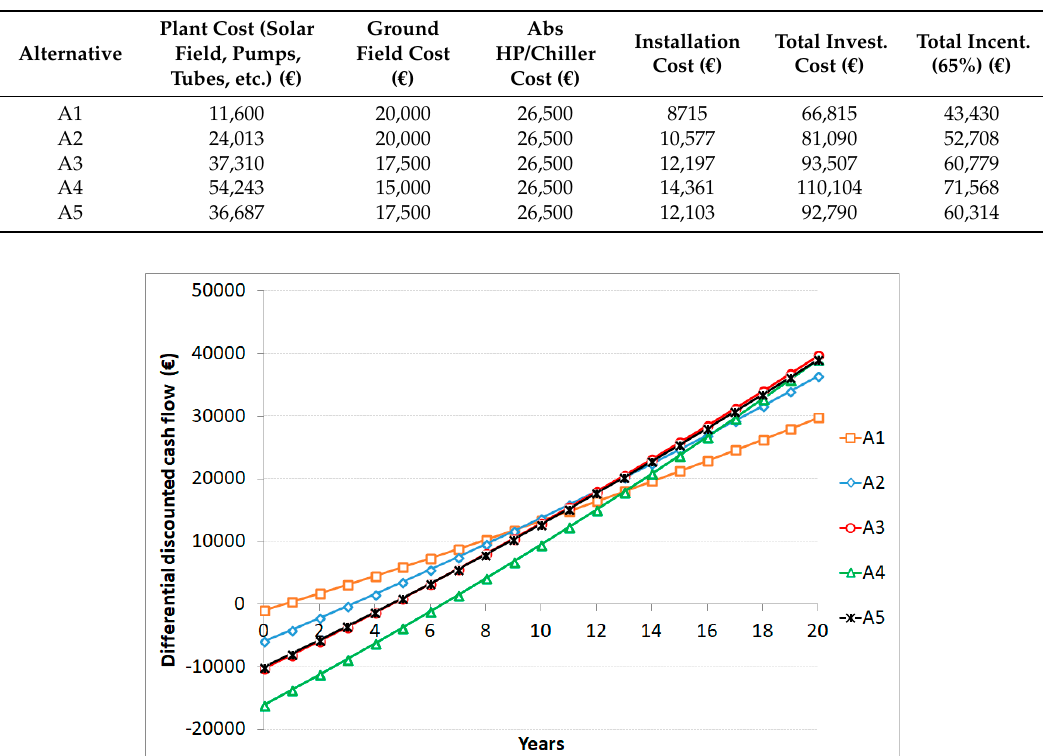
Figure 17. Annual discounted differential cash flows between the A1–A5 alternatives and the traditional one (A0).